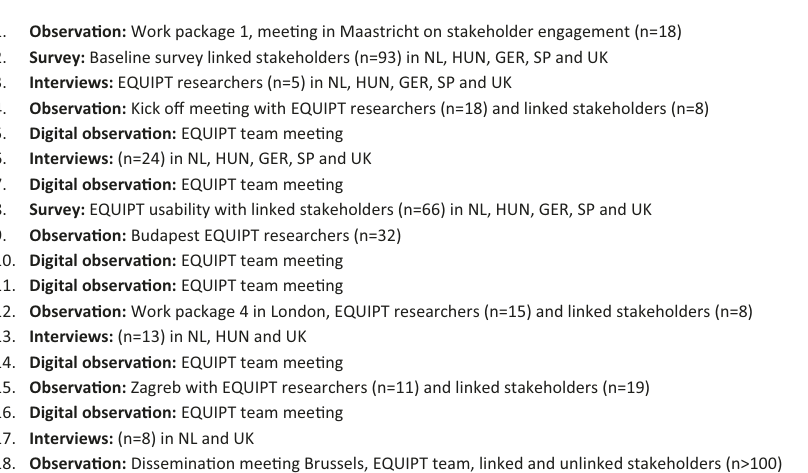
Fig. 1 SEE-Impact data collection: different stages and types of activities over the 3-year study. Each top panel denotes the year in which the activities beneath took place. The fi rst (upper) horizontal line below the top panel marks EQUIPT activities in relation to eachyear. The second (lower) horizontal line depicts the various SEE-impact datacollection activities that took place. The numbered arrows show the type of datacollection in relation to EQUIPT activities and each year of the